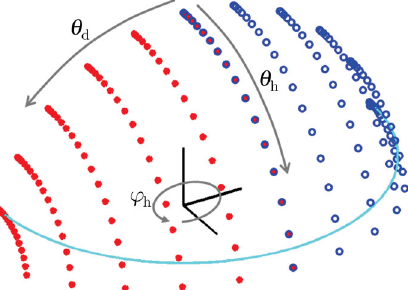
Fig. 7 The minimal set of 108 bidirectional samples needed to capture effect coating appearance in half-difference parameterization for fixed ϕ d = 90 ◦ and angular steps Δ θ h / Δ θ d = 5 ◦ / 15 ◦ . The incoming (red) and outgoing (blue) directions span a quarter hemisphere and are symmetrical. The cyan line represents maximal elevation angles captured resulting in 83